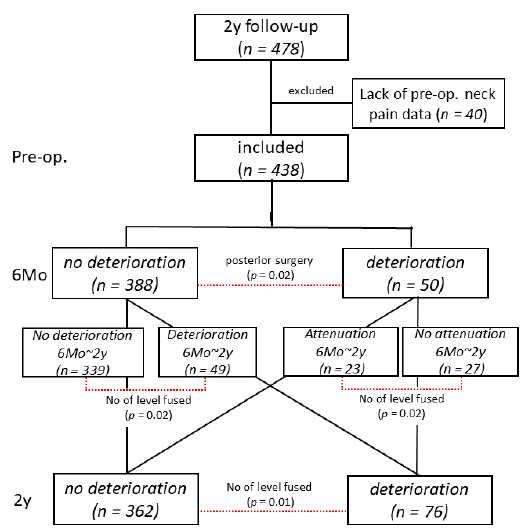
Figure 1. Patients who had undergone cervical spine surgery for myelopathy caused by cervical OPLL. We excluded those without evaluation of preoperative neck pain. We ultimately included 438 patients with treated cervical OPLL. Table 1. Patient demographics.